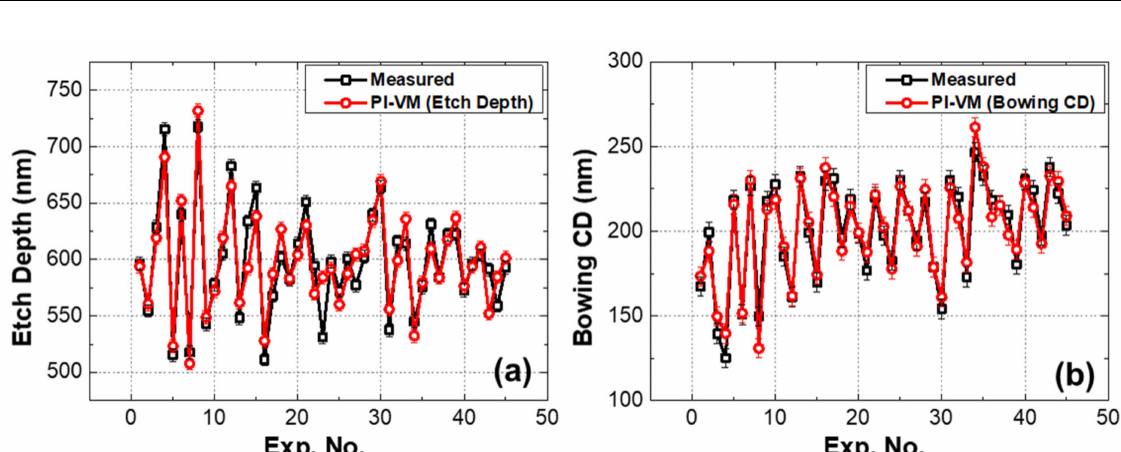
Figure 6. Comparison between the measured values (black) and PI-VM prediction values (red) ( a ) measured and PI-VM prediction values of etch depth ( b ) measured and PI-VM prediction values of bowing CD. The error of each value is 5.7 nm, which is the pixel size of the SEM